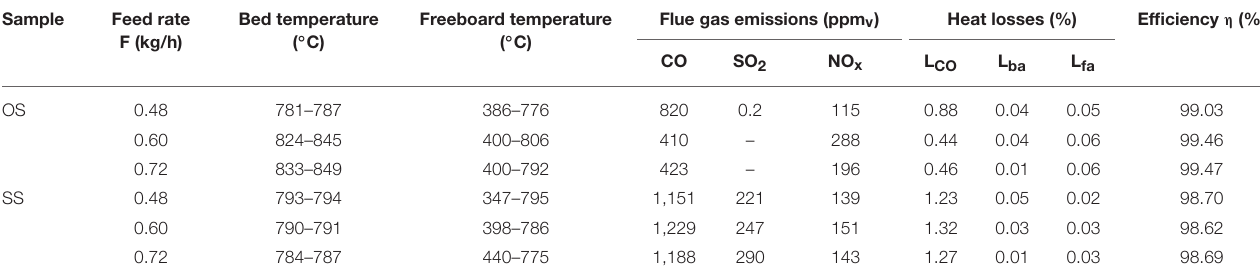
TABLE 3 | Fluidized bed combustion performance of fuels at different feed rates and excess air ratio 1.4. Sample Feed rate F